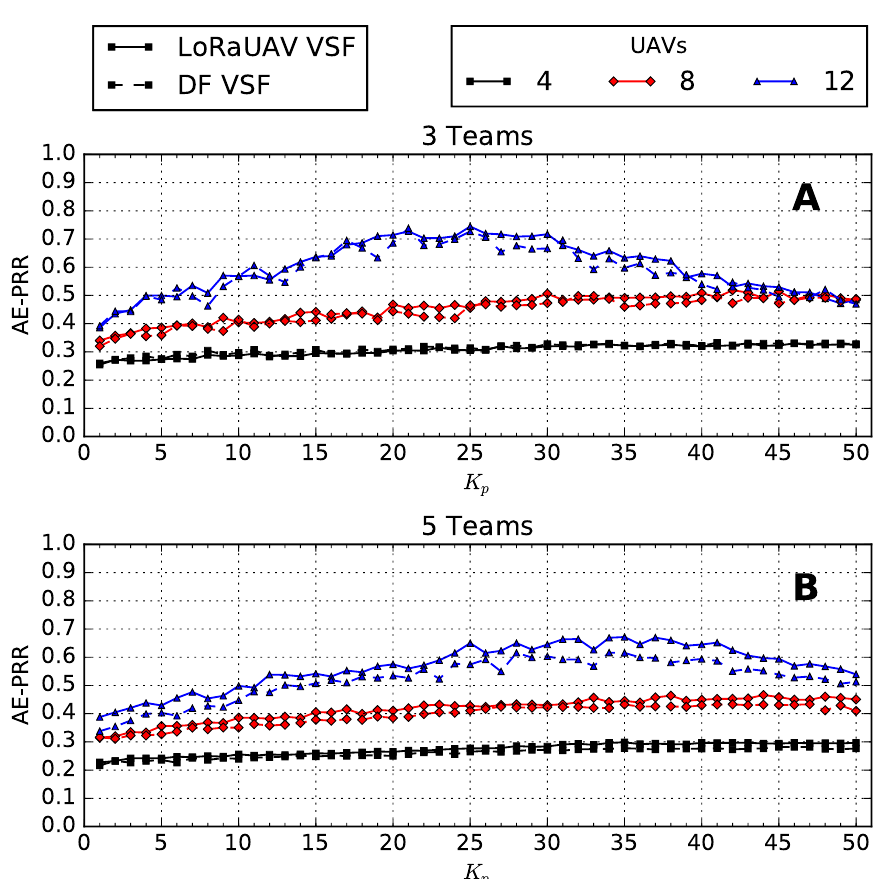
Figure 4. Average End-to-End Packet Reception Ratio (AE-PRR) comparison when the LoRaUAV Virtual Spring Force (VSF) algorithm and the DF VSF algorithm are used in a scenario with three ( A ) and five ( B ) teams of 20